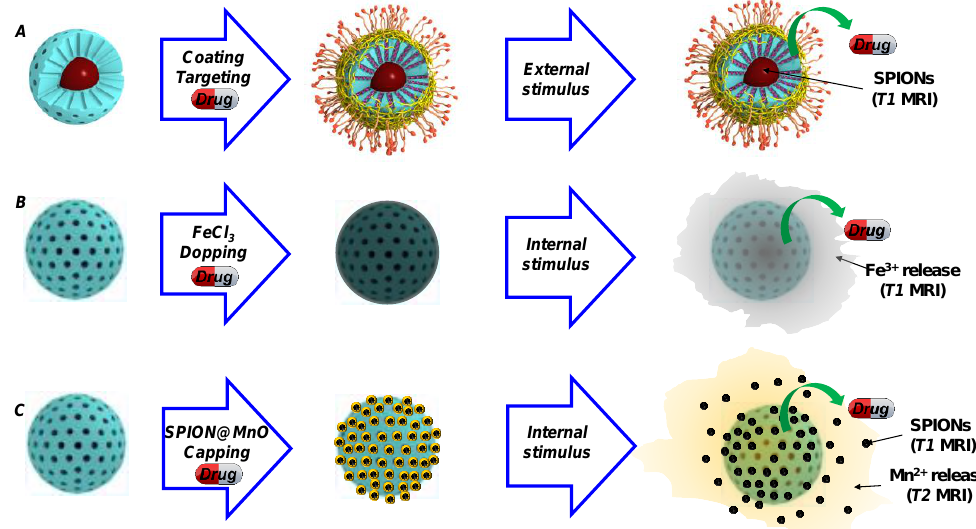
Figure 4. Possible strategies for the preparation of mesoporous silica-containing composites for MRI detection. ( A ) SPIONS contained in IOMSNs enable T1 weighted MRI, while the outer mesoporous silica shell facilitates the development of hyperthermia-triggered systems. ( B ) Doping the silica matrix with acidic cleavable contrast cations for T1 weighted MRI. ( C ) Capping mesopores with doped SPIONs for favoring acidic release of T1 (SPIONs) and T2 (Mn 2+ ) contrast agents.